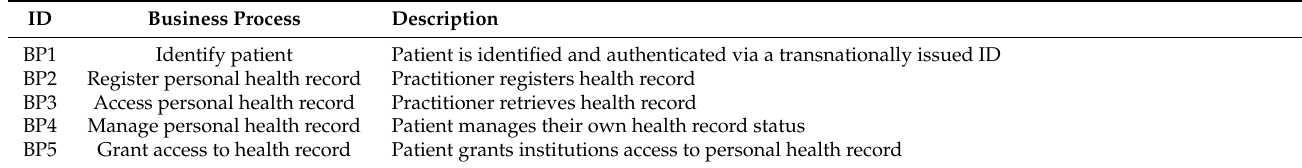
Table 3. Business process for the Transnational Health Record (THR) system.